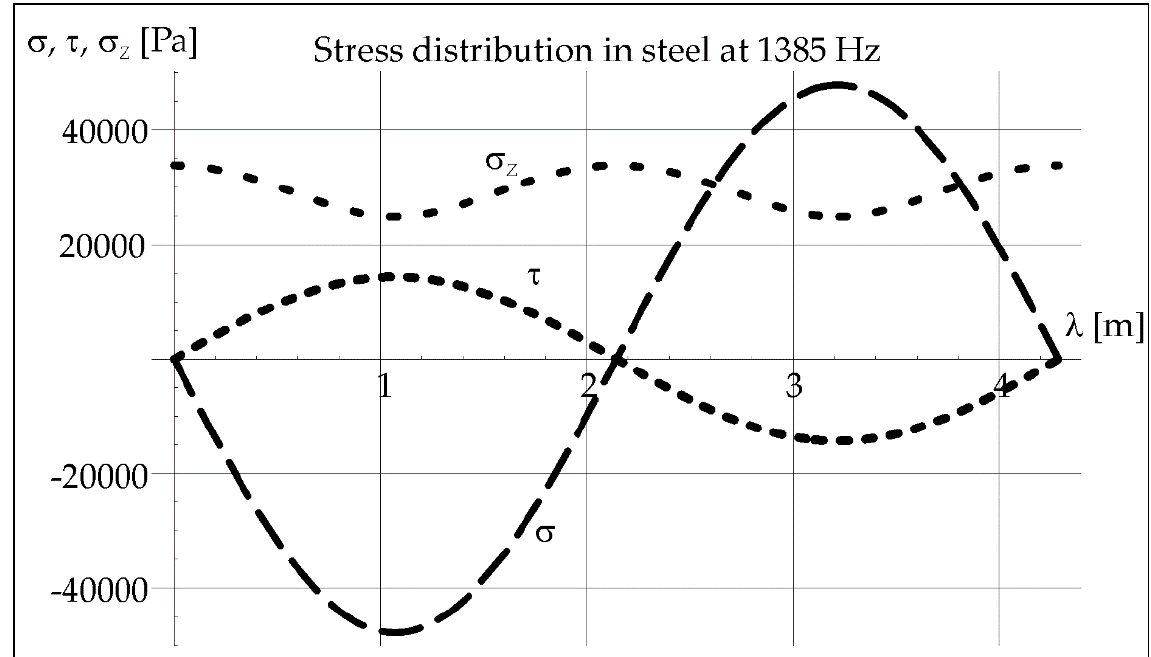
Figure 19. Stress distribution in steel at 1385 Hz.